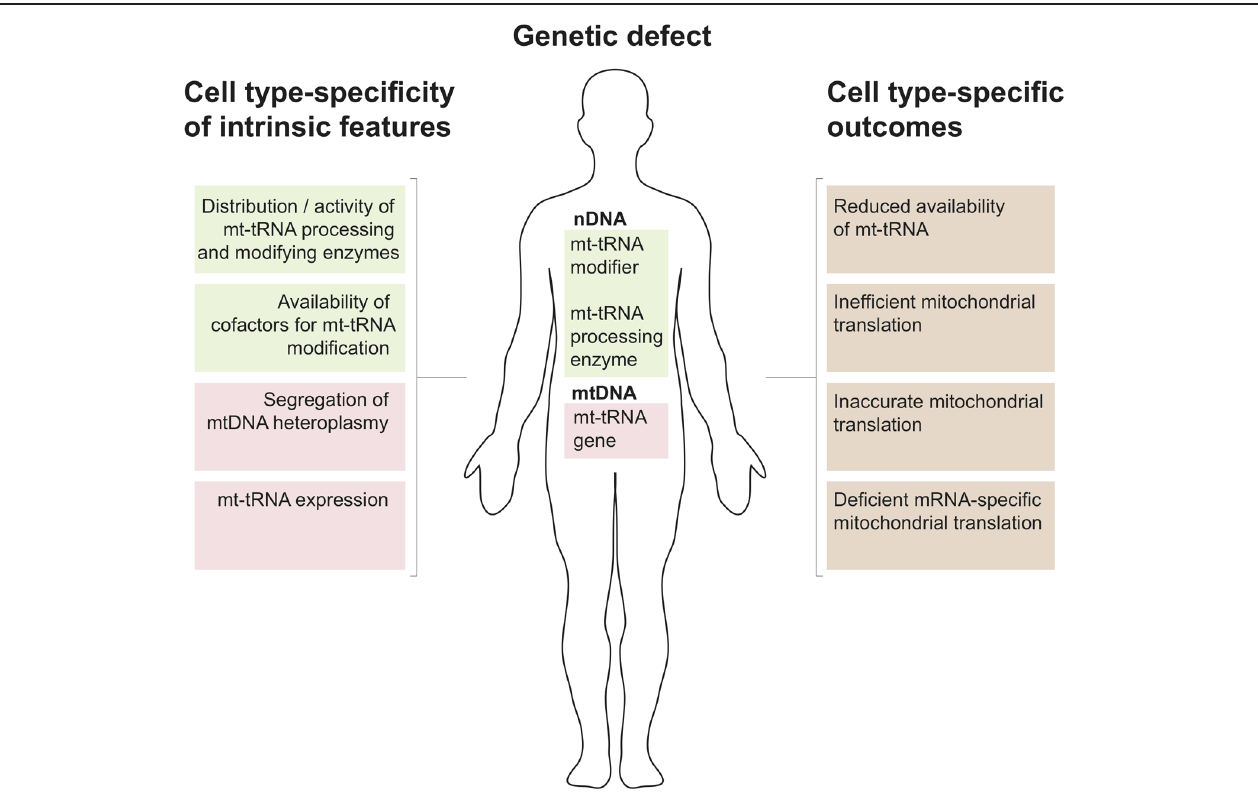
FIGURE 3 | Mitochondrial tRNA metabolism and tissue specificity of associated disease. Several properties that relate to tissue-specific regulation of mitochondrial tRNA biology by nuclearly- (green) and mitochondrially encoded genes (red) are listed to the left. Possible genetic defect leading to perturbations of mitochondrial tRNA metabolism